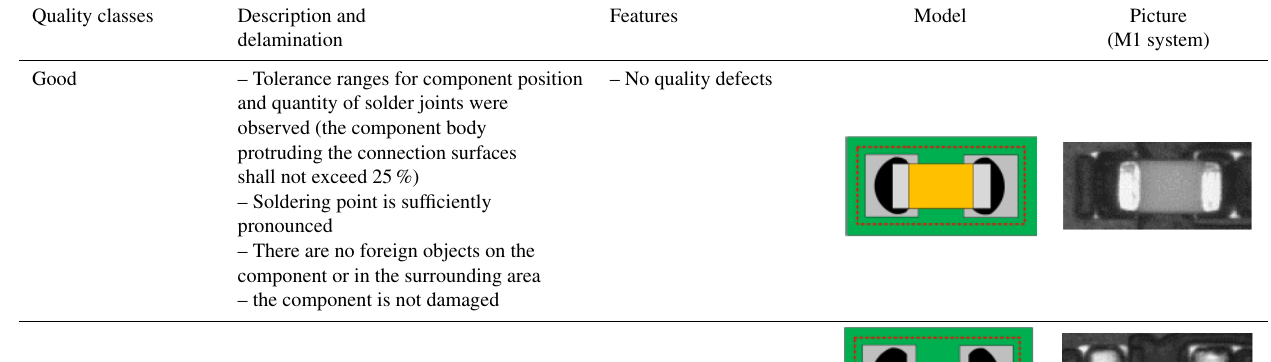
Table 1. Definition of the quality classes of the chip component for the neural network (Berger, 2012). Quality